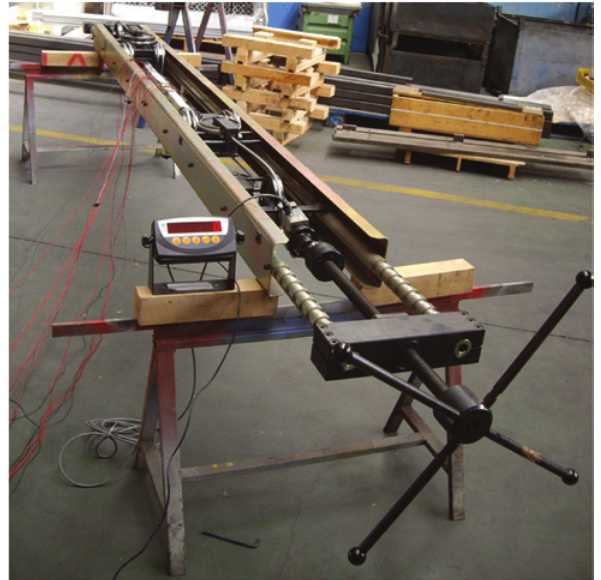
Figure 12 Top view of the test ring [12].